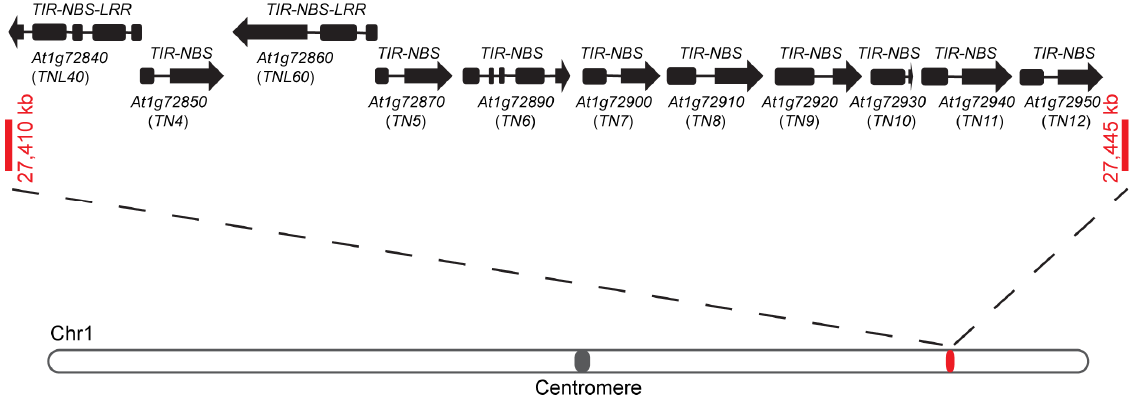
Figure 1. Schematic description of the largest Toll/interleukin receptor ( TIR ) -nucleotide binding site ( NBS ) -type ( TN ) gene cluster with two typical TIR - NBS - leucine-rich-repeat ( TNL ) genes, TNL40 and TNL60 . Exons and introns are represented by black boxes and solid lines, respectively. Arrows indicate the orientation of genes. The long bar at the bottom represents Arabidopsis chromosome 1. The gray dot represents the position of the centromere and the red dot represents the location of the indicated TN gene cluster. The red bars and numbers represent the boundaries of these TN gene cluster.